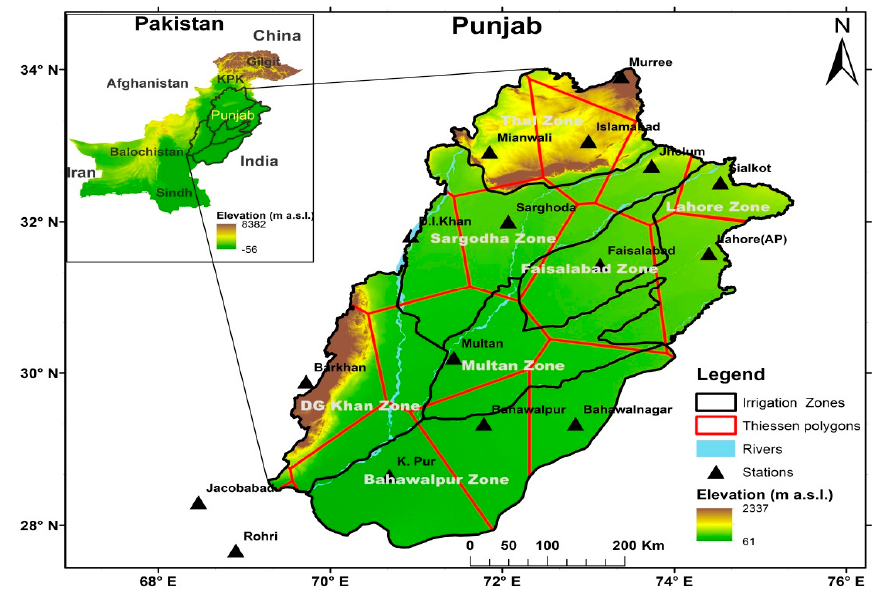
Figure 1. Location of the Punjab irrigation zones, climatic stations, and corresponding Thiessen